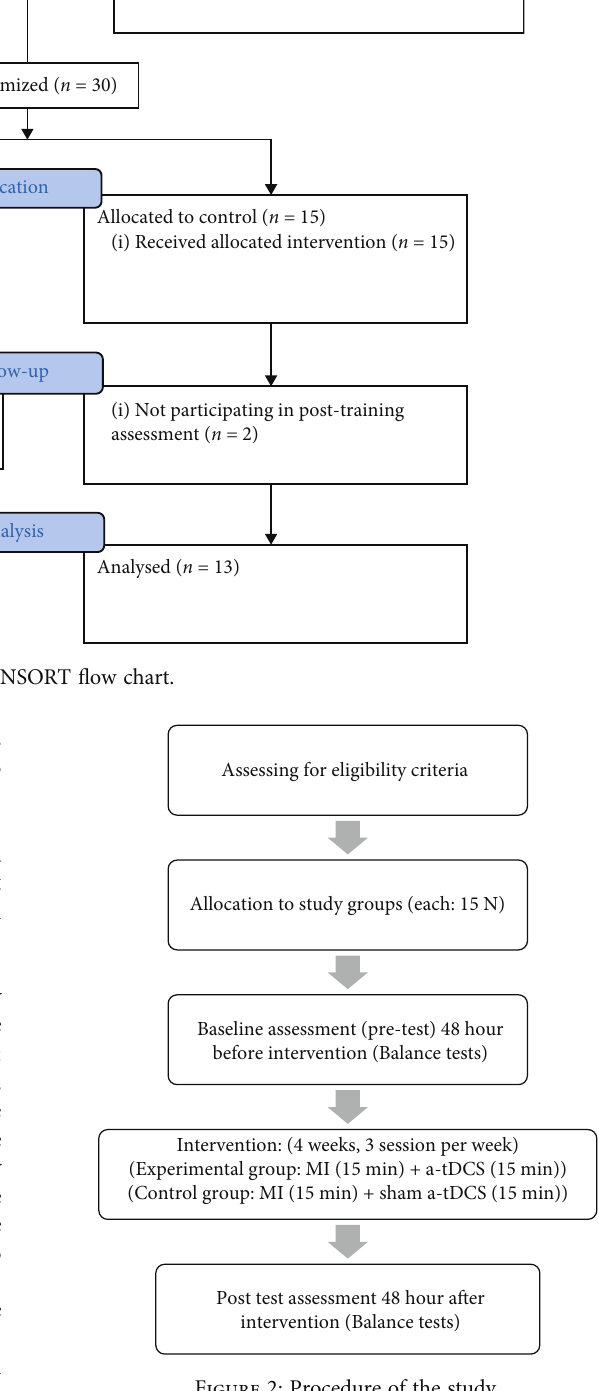
Figure 2: Procedure of the